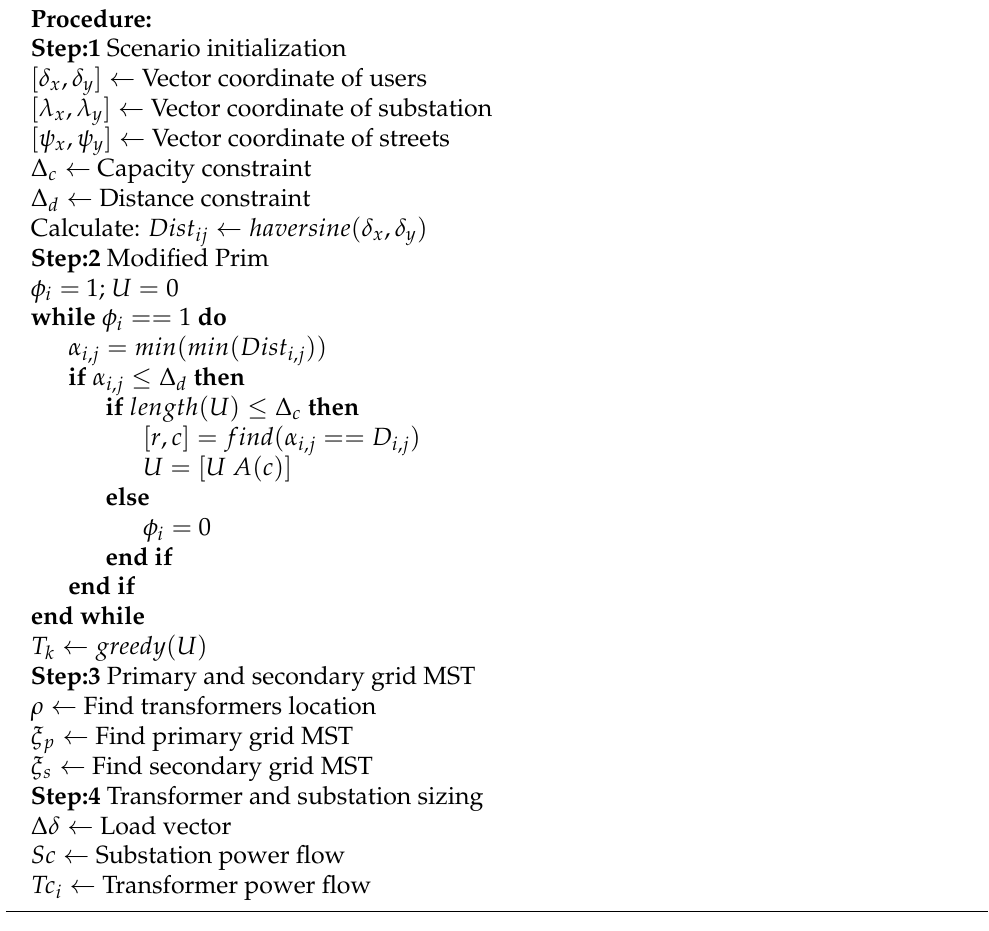
Algorithm 1 Reconfiguration Algorithm.